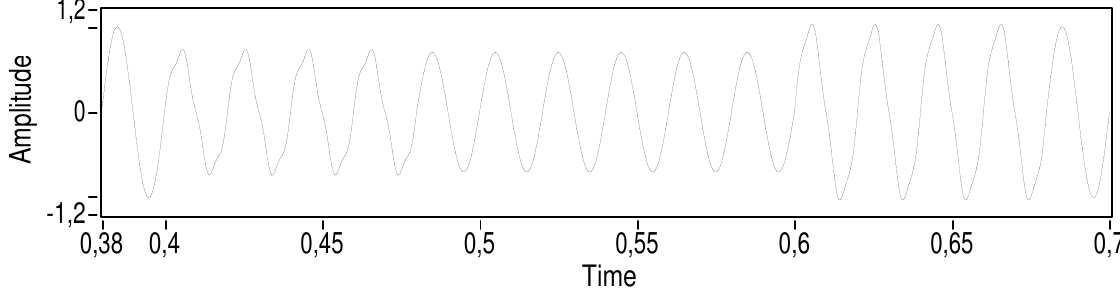
Figure 6. Sag with harmonic distortion. Time series of a sag with a depth of 30% and a duration of 10 cycles with harmonic distortion with an amplitude of a 0.07 and a duration of four cycles of the power signal. The fourth harmonic has been selected (200 Hz).